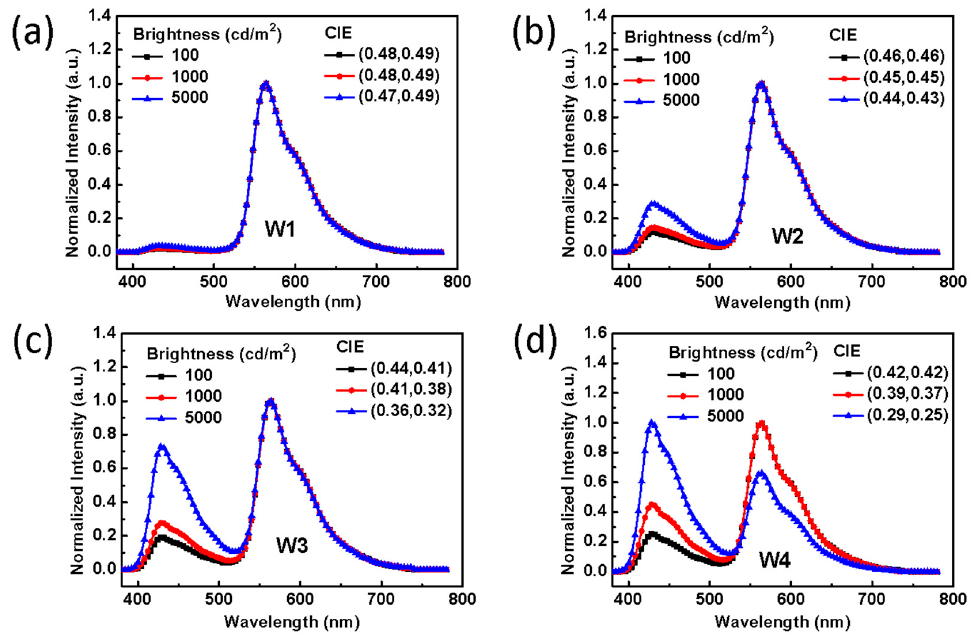
Figure 4. The normalized electroluminescence (EL) spectra and corresponding CIEs of ( a ) W1, ( b ) W2, ( c ) W3, and ( d ) W4 at luminance of 100, 1000, and 5000 cd/m 2 .